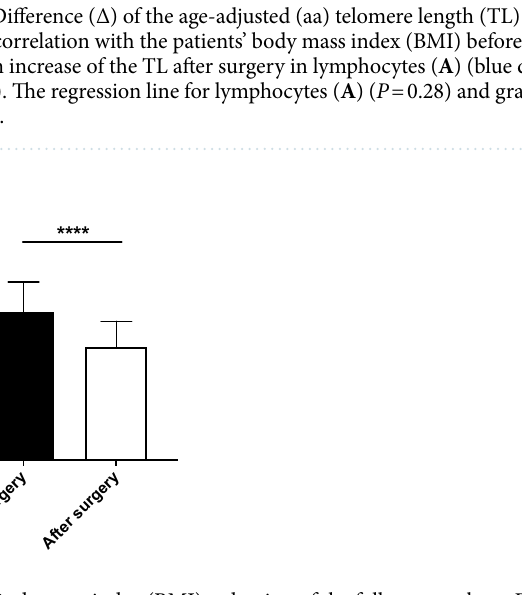
Figure 3. Body mass index (BMI) reduction of the follow-up cohort. BMI before and after surgery of 35 patients is shown. BMI was significantly reduced from 51.7 ± 1.8 kg/m 2 to 39.5 ± 1.5 kg/m 2 ( P < 0.0001; Student’s